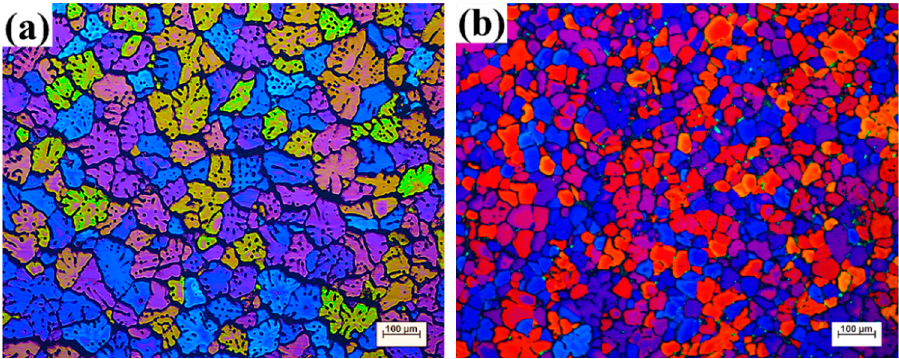
Figure 3. Optical microstructures of squeeze castings of the test alloy under two conditions: ( a ) Without